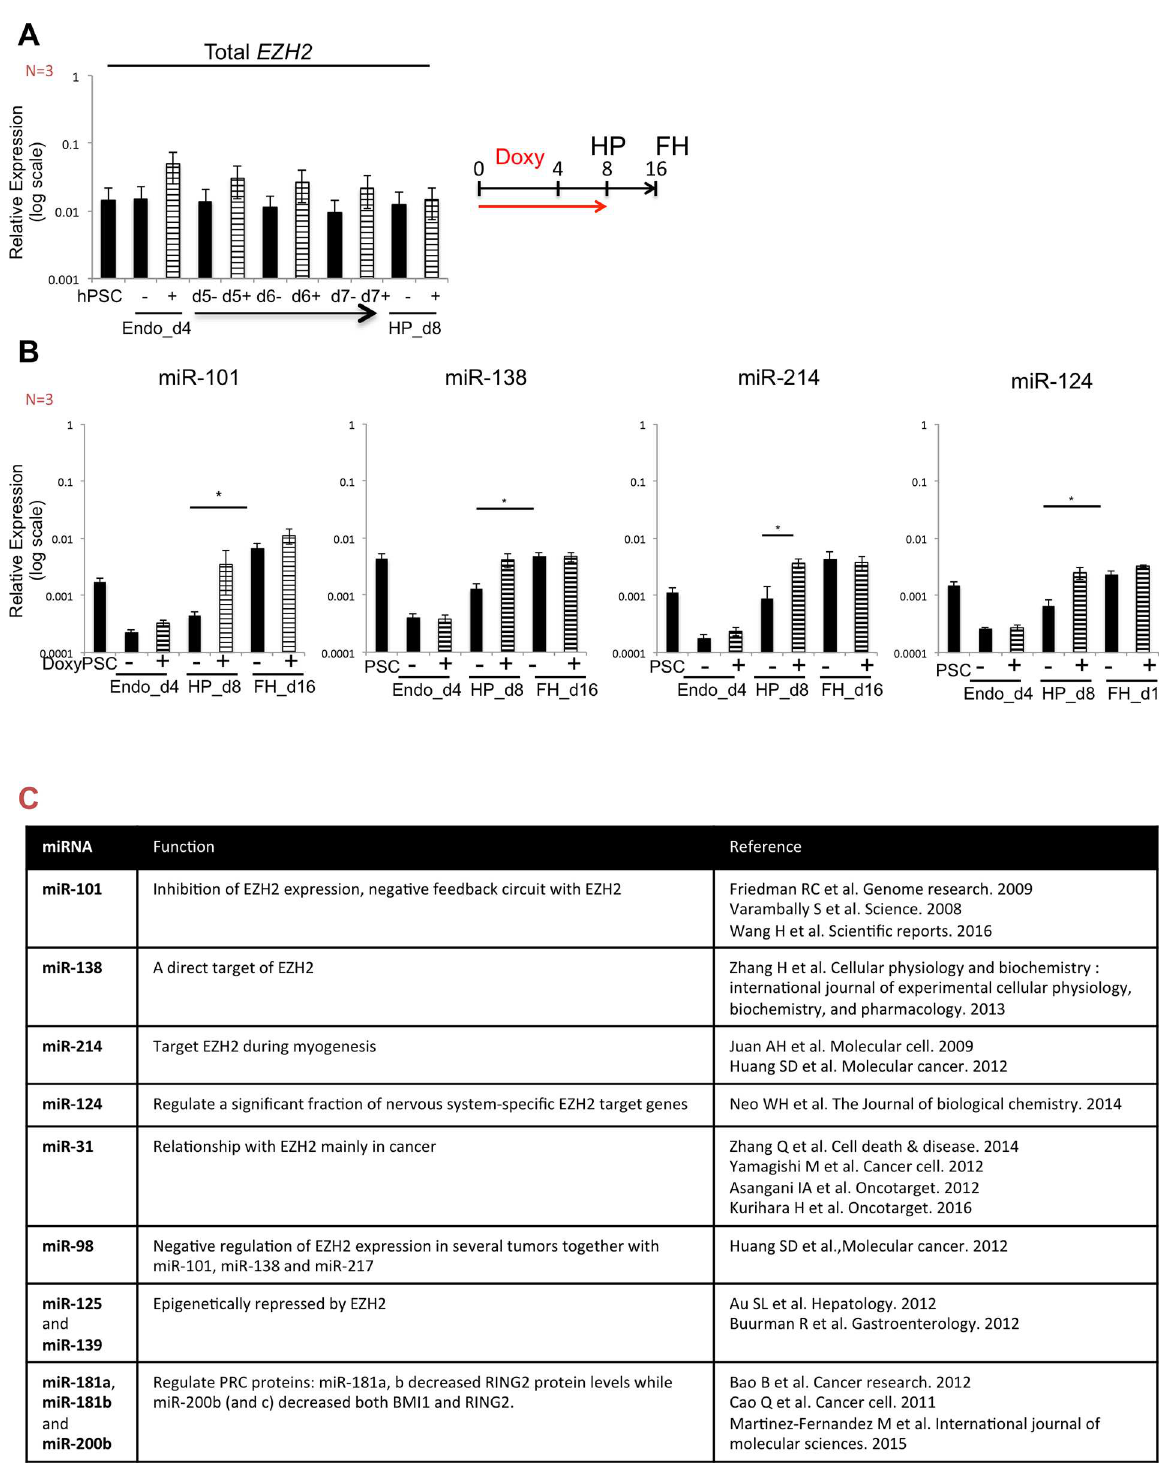
Fig 5. miRNA and EZH2 mRNA degradation. A. Relativegene expression(to GAPDH ) of endogenousand exogenous EZH2 (Total EZH2 ) daily duringthe transition from endodermstage (day 4, endo_d4) to hepatoblastprogenitor(day 8, HP_d8) in untreated (-) and EZH2 doxy inducedcells (+). Data as mean ± SEM of n = 3 IEs. B. Relativeexpressionof miR-101, miR-138, miR-214and miR-124 duringhepatocytesdifferentiationfrom hPSC- i EZH2 cell line doxy inducedthe first 8 days of differentiation. Relativegene expressionto U6. Data as mean ± SEM of n = 3 IEs. C. Name, functions and reference papers of the miRNAs analyzed.